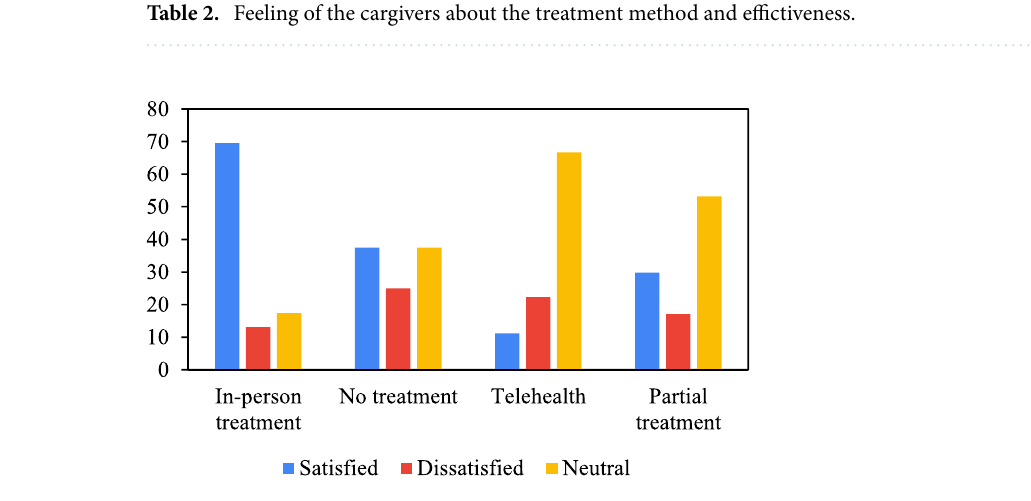
Figure 2. Percent of satisfaction for each speech therapy method provided by